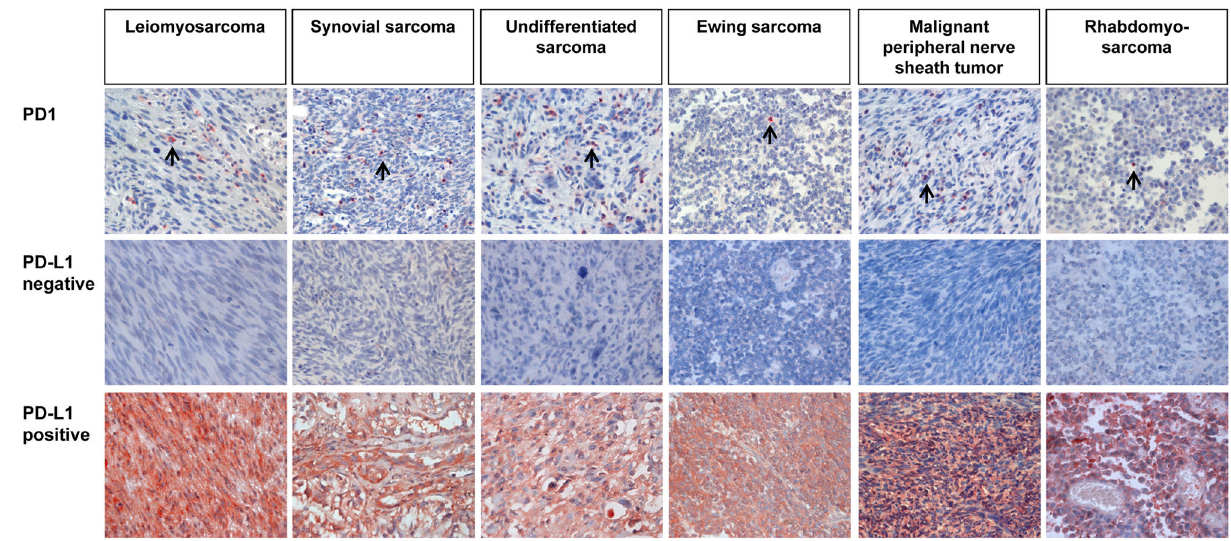
Figure 1. Immunohistochemical expression of PD1 and PD-L1 in various soft-tissue sarcomas. Arrows indicate PD1 positive lymphocytes. Original magnification, x400.